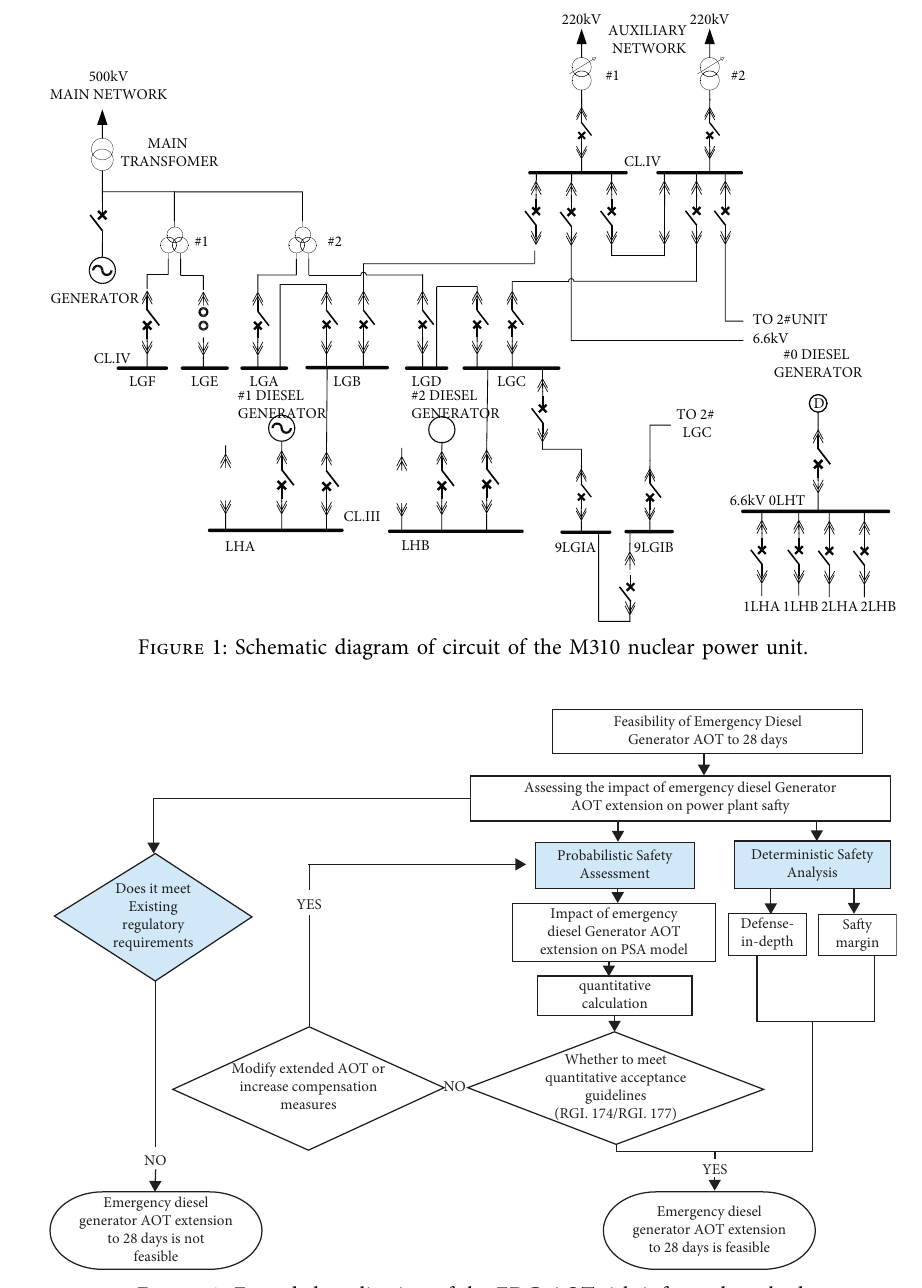
Figure 2: Extended application of the EDG AOT risk-informed method.